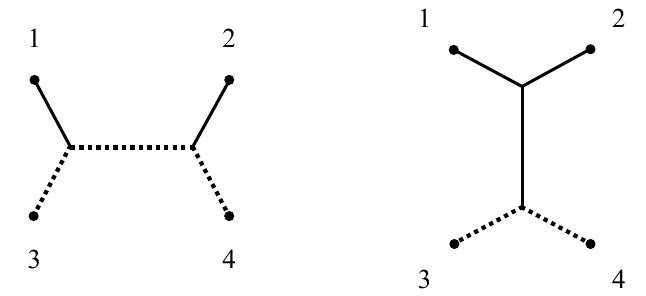
Figure 1 . Emission of untwisted strings from twisted sector or t -channel picture of A 4 (left), and s -channel picture (right). The solid/dashed lines represent the propagation of the un- twisted/twisted